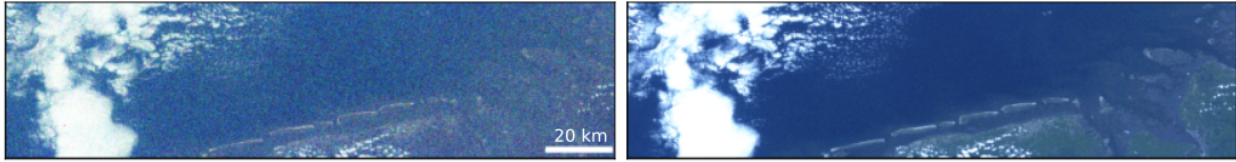
Figure 12. The first HICO North Sea scene adjusted to a signal-to-noise ratio of 1 for the median observation value ( left ). The same noisy scene after being reconstructed from data clustered by an SOM ( right